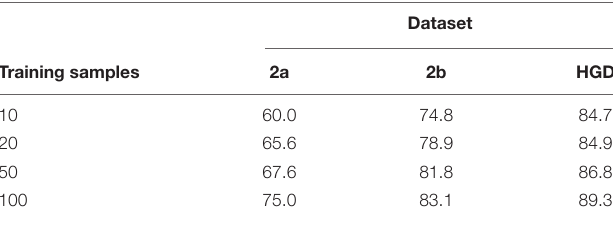
TABLE 4 | Results of fine-tuning on a small number of training